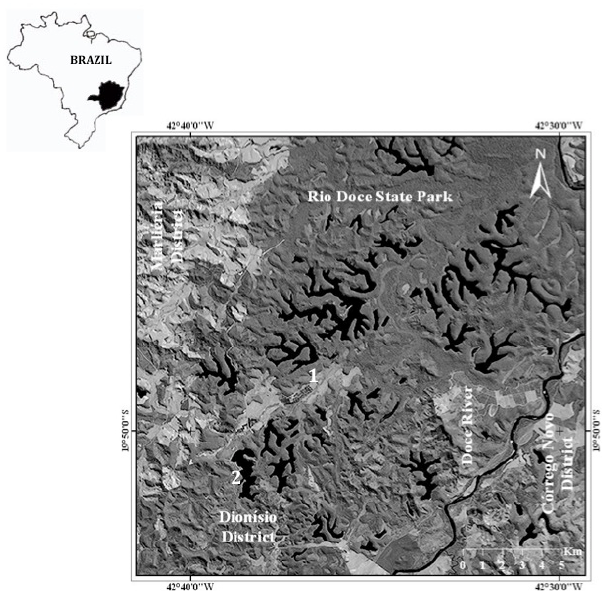
Fig. 1. Geographic locations of the studied lakes surrounded by Atlantic Tropical Forest in Southeast Brazil: (1) Lake Barra and (2) Lake